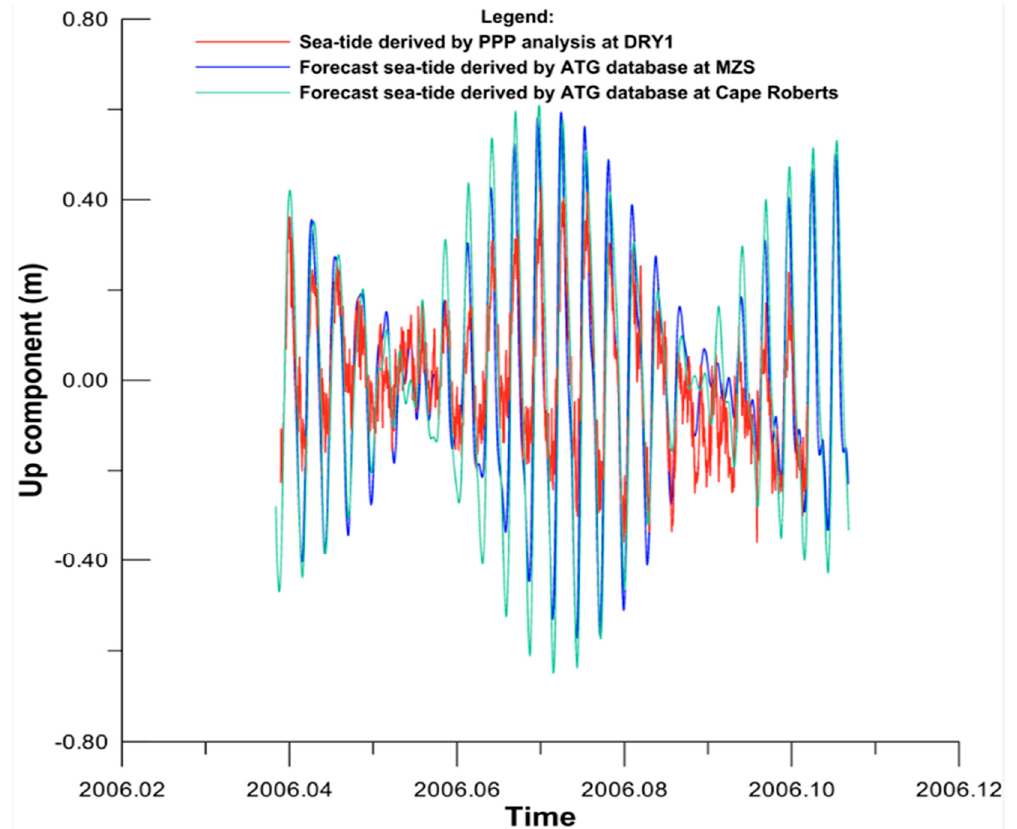
Figure 7. Comparison between the time series of the Up component obtained from the PPP calculation of the GNSS observations acquired at DRY1 and the predicted ocean-tide calculated from Q1, O1, P1, K1, N2, M2, S2, K2 harmonic coefficients published in the ATG database for two sites: MZS (about 100 km north of DRY1) and Cape Roberts (about 170 km south of DRY1). The diurnal declinational tides K1 and O1 are the most important tides, which occur once a day. In the Ross Sea, as well as in the coasts between 65 ◦ W to 140 ◦ E, there is a tide cycle per day; the lunar phases almost do not affect the tides. This confirms Thiel et al. [31], who first showed that the Ross Sea tide is diurnal and that the solar component